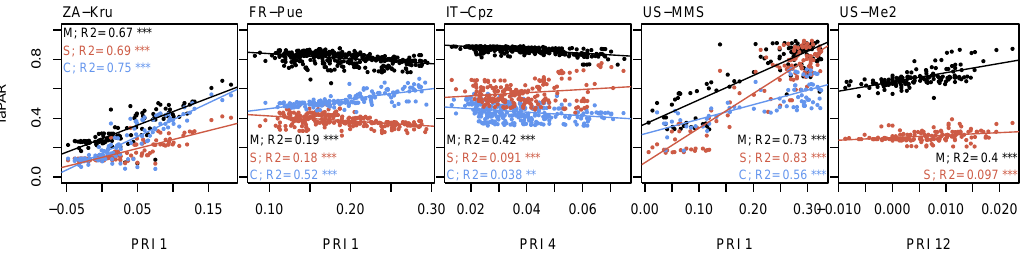
Fig. 5. Scatterplots with R 2 of faPAR from different products (Black: MODIS – M), Red: SeaWiFS – S, Blue: Cyclopes – C) vs. PRI with site-specific most suitable reference band. Significance codes: p value ≤ 0.001: ∗ ∗∗ ; p value ≤ 0.01: ∗